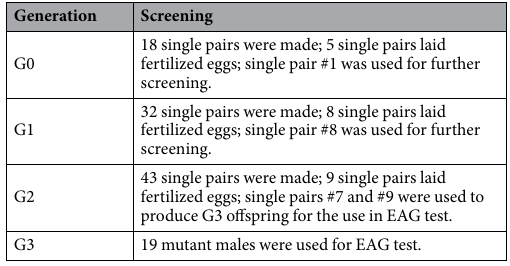
Table 1. Screening of the HarmPBP1 homozygous mutants. The RED assay results were showed in Fig. 2, for those adults from the single pairs that laid fertilized eggs.